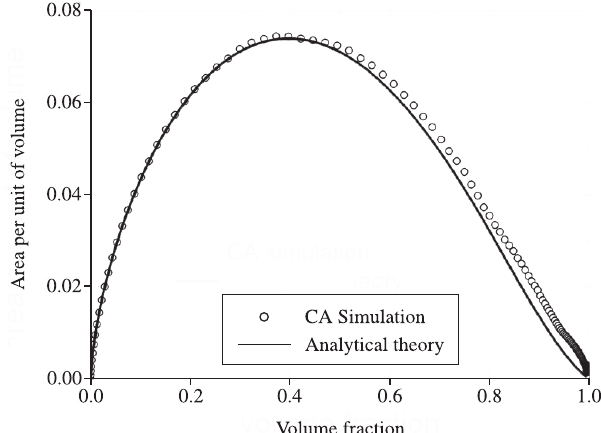
(t, x) as a function of time at planes V